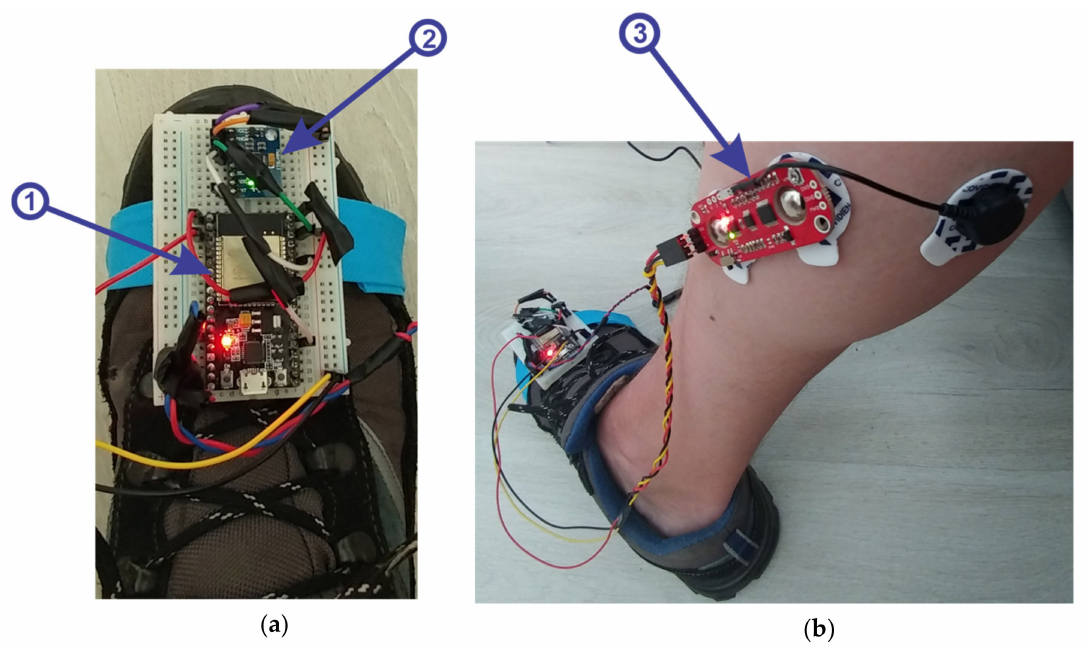
Figure 2. ( a ) Device for retrieving and sending data from sensors to the Server application. ( b ) MyoWare—electromyography sensor